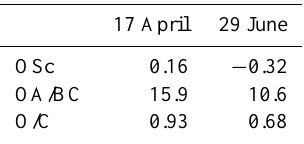
Table 4. Mean in-plume oxidation state values (OS C ), OA/BC, and AMS O/C ratios for 17 April and 29